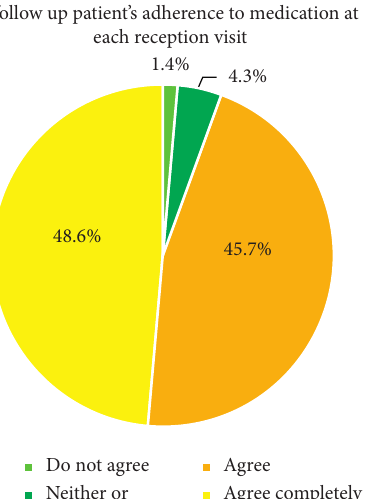
Figure 2: Proportions of healthcare professionals who follow up adherence to Table 3: Comparisons between preintervention and postintervention regarding readiness for adherence support. Variable